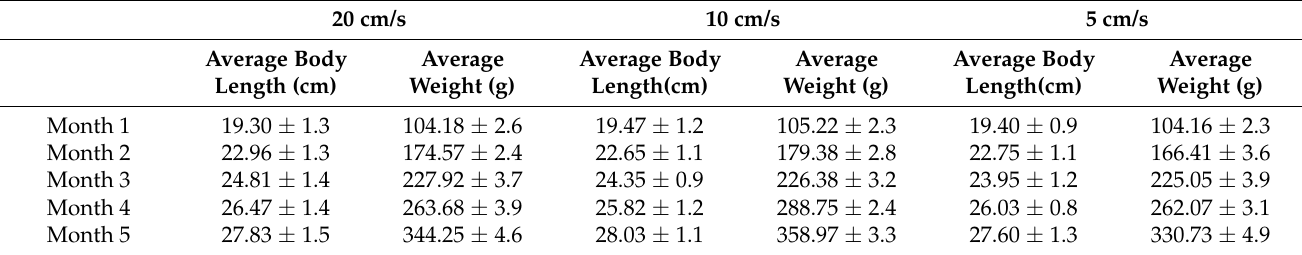
Table 1. Changes in body length and body weight of P. leopardus under different flow